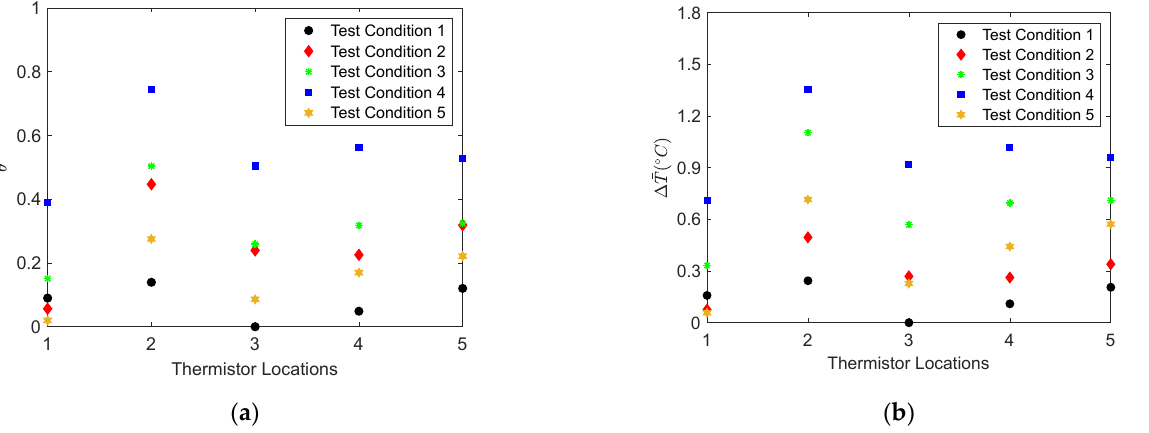
Figure 9. Time ‐ average, ( a ) dimensionless temperature difference, and ( b ) temperature difference at each thermistor location for Test Conditions 1 to 5.